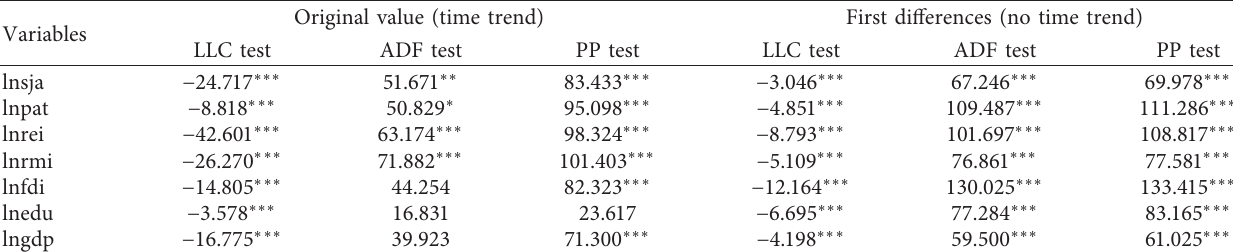
Table 2: Unit root test results.